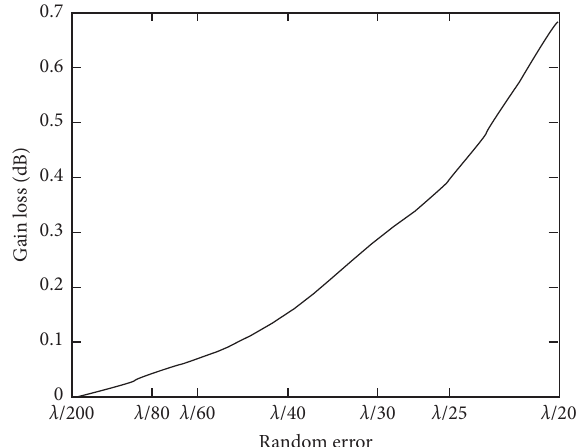
Figure 11: Gain loss versus random error of element position [79].